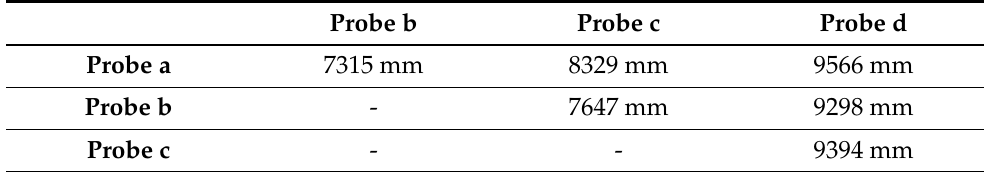
Figure 1. Configuration of Electric Field Detector (EFD) on-board the China Seismo-Electromagnetic Satellite (CSES). The reference frame ( X s , Y s and Z s ; X s is directed along the satellite motion) is the satellite orbit system (see explanation in the text). Adapted from Huang et al. [2]. Table 1. Distance between probes. Adapted from Huang et al.